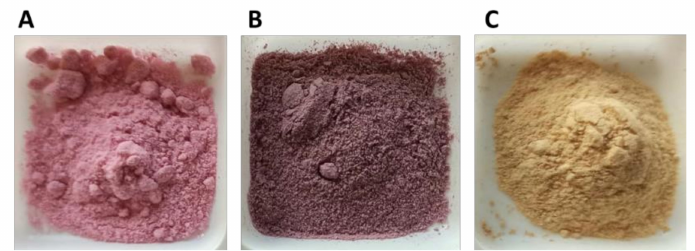
Figure 8. Sangiovese ( A ), Merlot ( B ) and Viognier ( C ) UG extracts.